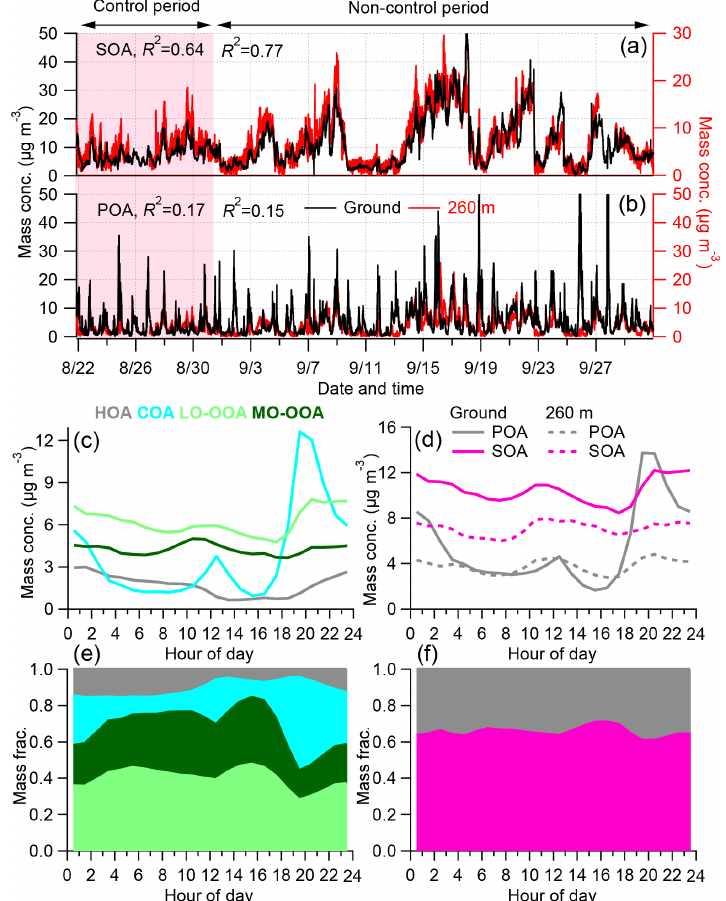
Figure 5. (a, b) A comparison of time series of SOA and POA at ground and 260m, (c) diurnal variations of four OA factors at the ground site, (d) diurnal variations of POA and SOA at the ground site and 260m and (e–f) the diurnal mass fractions of OA factors in (c) at ground and (d) at